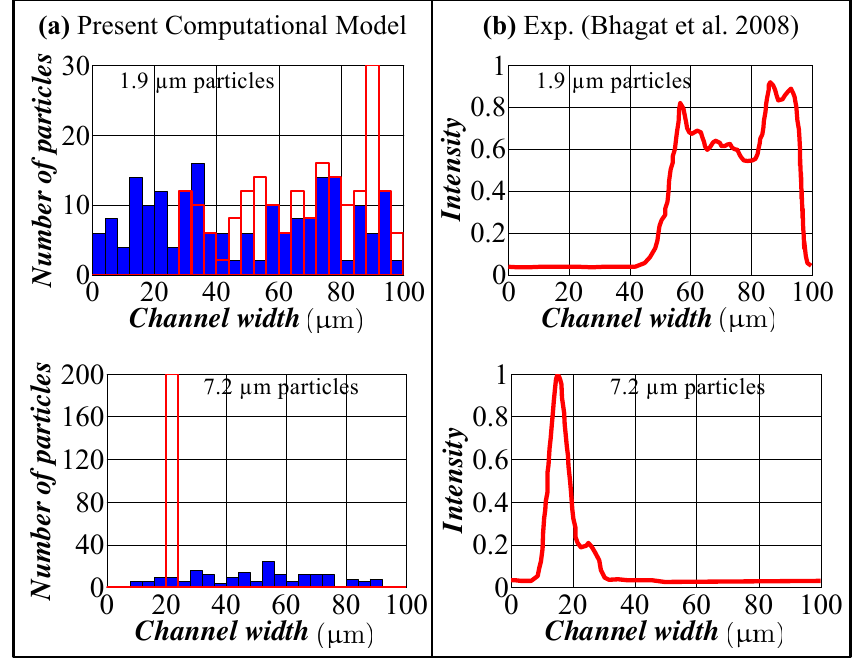
Figure 2. Comparison of the particle distribution for 1.9 µ m and 7.2 µ m particles (Q = 0.6 mL/h). ( a ) Results from present computational model; ( b ) experimental results (adapted from [9]). Blue bars: particle distribution at the inlet. Red bars: particle distribution at the